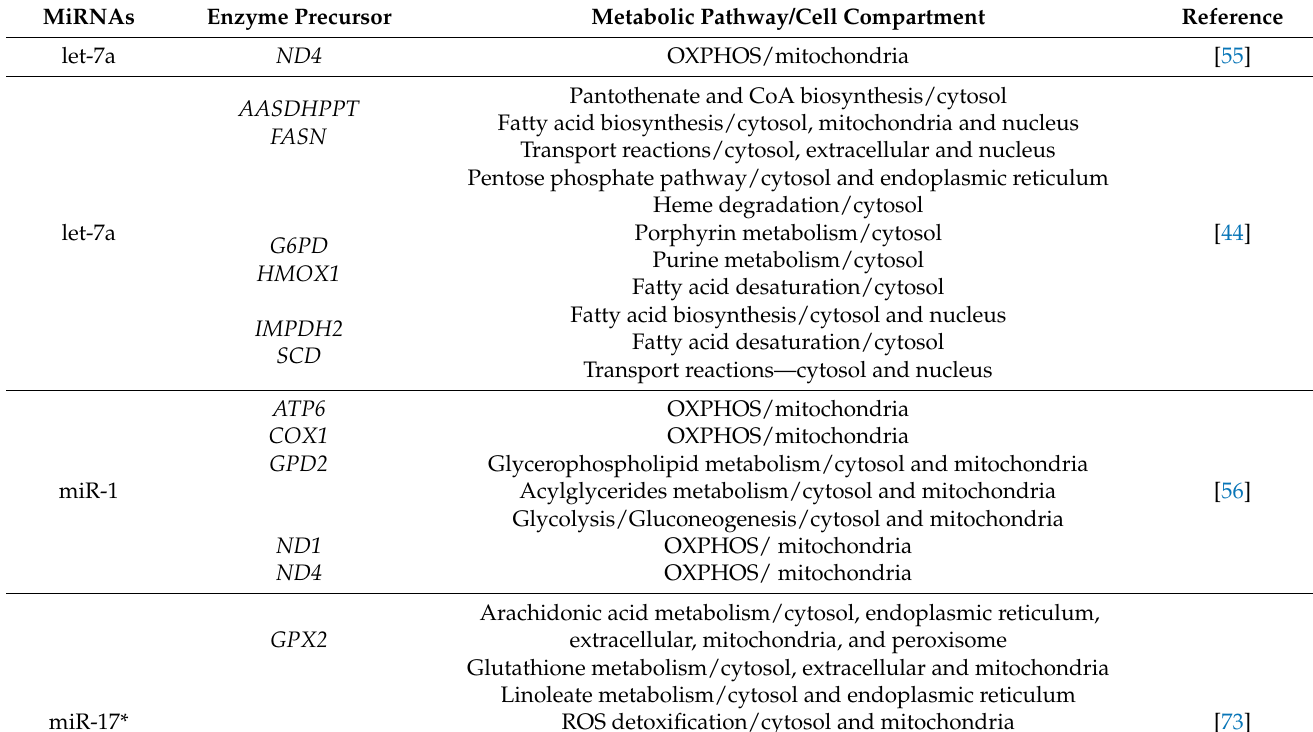
Table 3. Enyzme’s precursors and corresponding metabolic pathways targeted by the oncogenic and tumor suppressor